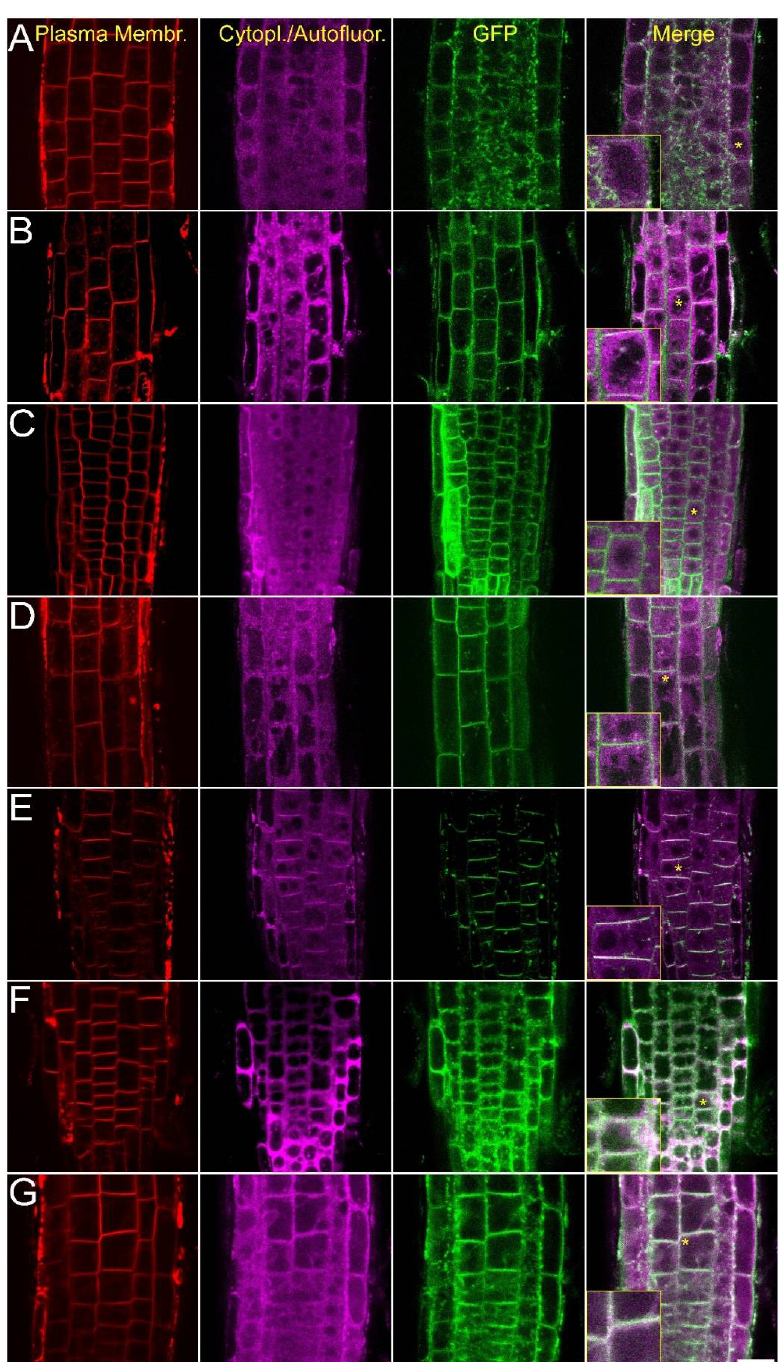
Figure 2. Intracellular localization of the AtCRK-eGFP fusion proteins. AtCRK protein localization in root cells of transgenic Arabidopsis plants expressing the pCaMV35S::CRK-eGFP gene constructs. FM4-64 dye labeling indicates plasma membranes (red, first column). Violet laser induced (excitation: 405 nm) cytoplasmic autofluorescence is shown in the second column (pseudocolored in magenta, detected between 425–475 nm). GFP-conjugated CRK protein images (green, CRK1 to CRK8) are merged with autofluorescence images at the last column where vacuoles appear as dark intracellular areas due to lack of autofluorescence and absence of CRKs. Yellow asterisks indicate regions from which 2× magnified closeup images (insets) are prepared. ( A ) AtCRK1-GFP; ( B ) AtCRK2-GFP; ( C ) AtCRK3-GFP; ( D ) AtCRK4-GFP; ( E ) AtCRK5-GFP; ( F ) AtCRK7-GFP; ( G ) AtCRK8-GFP. Bar = 20 µm.